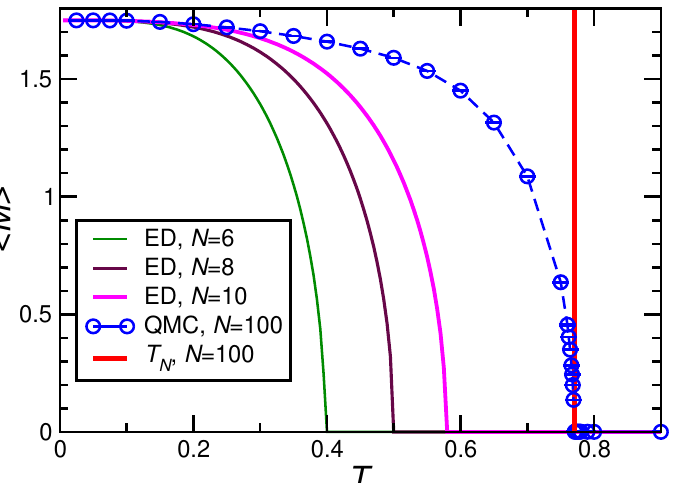
Figure 8. Self-consistent mean-field results for the magnetization (cid:104) M (cid:105) with J ⊥ = − 0.072/2.8, D = 0.36/2.8, h = 0, J = 1. The vertical line indicates the estimate T N = 0.77 for the Néel temperature obtained from chains with N = 100 sites (for details, see